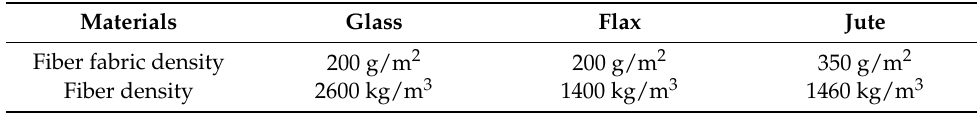
Figure 2. The material used in moisture absorption experiment. ( a ) Glass fiber fabric; ( b ) Flax fiber fabric; ( c ) Jute fiber plane weave fabric; ( d ) The manufacture process of composites; ( e ) Specimen. Table 1. The density of fiber fabric and fiber.